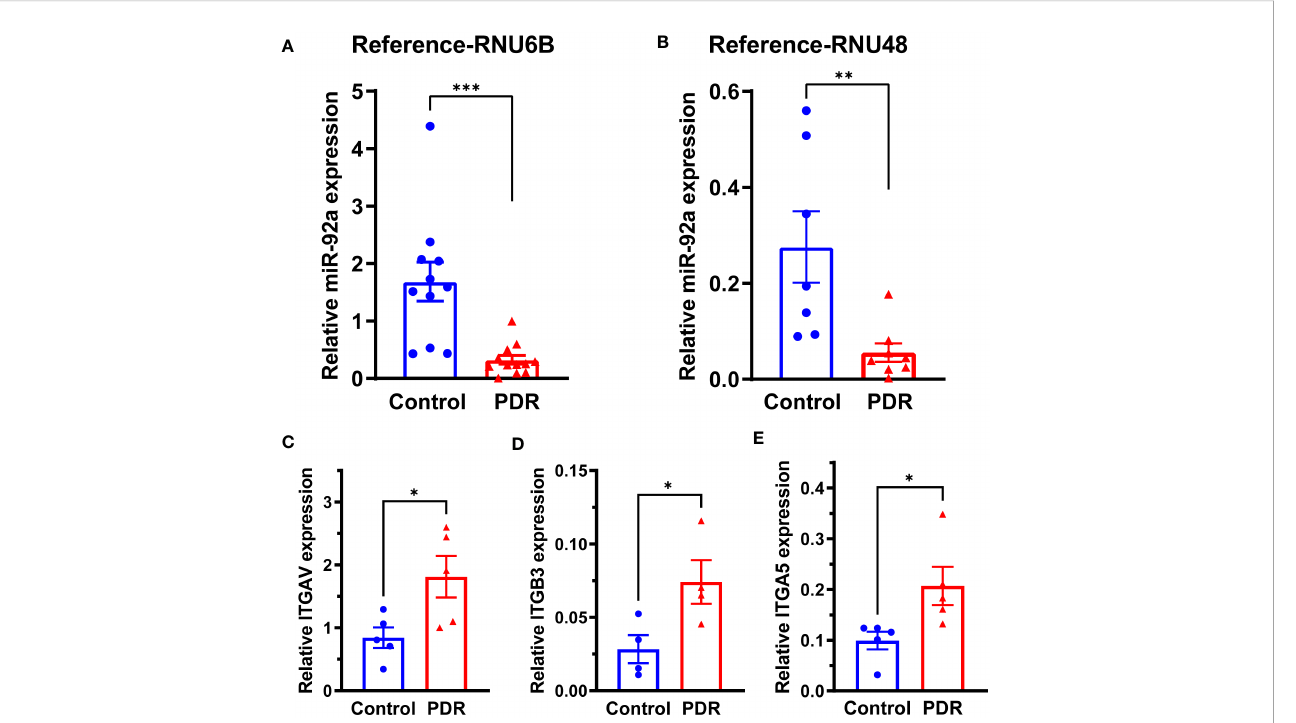
FIGURE 1 miR-92a decrease in FVM of individuals with PDR. Bar chart showing miR-92a levels in FVMs of individuals with PDR and epiretinal membranes of individuals with macular pucker using two separate housekeeping controls, (A) RNU6B (Control n=11, PDR n=12) and (B) RNU48 (Control n=7, PDR n=8). qRT-PCR was performed for mRNA targets of miR-92a, bar chart showing mRNA expression of (C) ITAGV (Control n=5, PDR n=5) (D) † ITAGB3 (Control n=4, PDR n=4) (E) ITAG5 (Control n=5, PDR n=5). n corresponds to biological replicate ***p<0.001, **p<0.01, *p<0.05, † outliers removed by Grubb ’ s